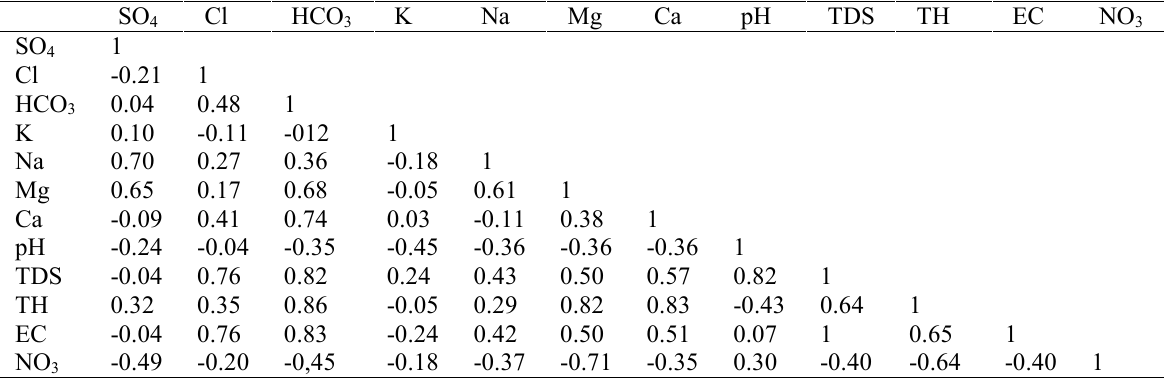
Table 2. Pierson correlation of groundwater analysis of the study area SO